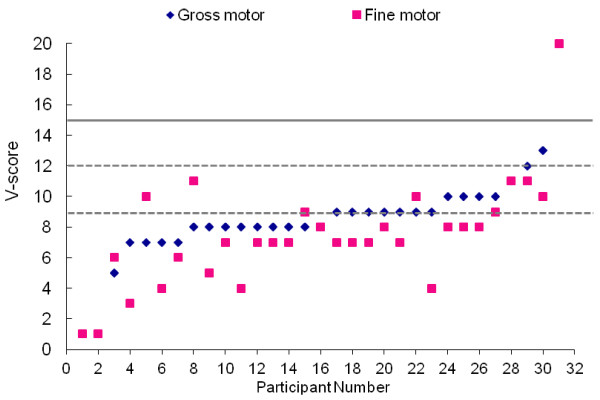
Motor functioning based on Vineland Adaptive Behavior Scales (n = 32) represented by V scores. Population mean (15) and standard deviation (3) are represented by solid and dashed lines, respectively.